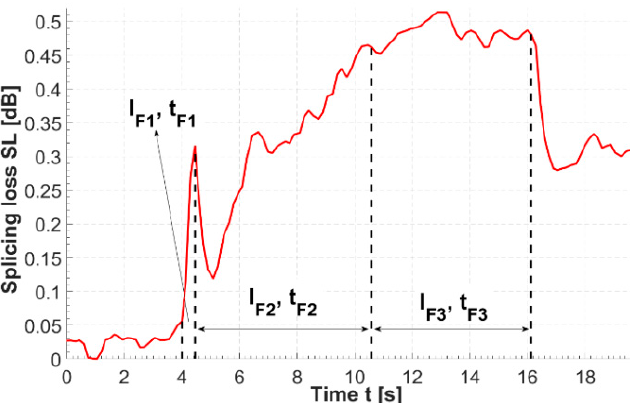
Figure A1. Evolution of splicing loss over time measured during the HCPBF-MMF splicing procedure.